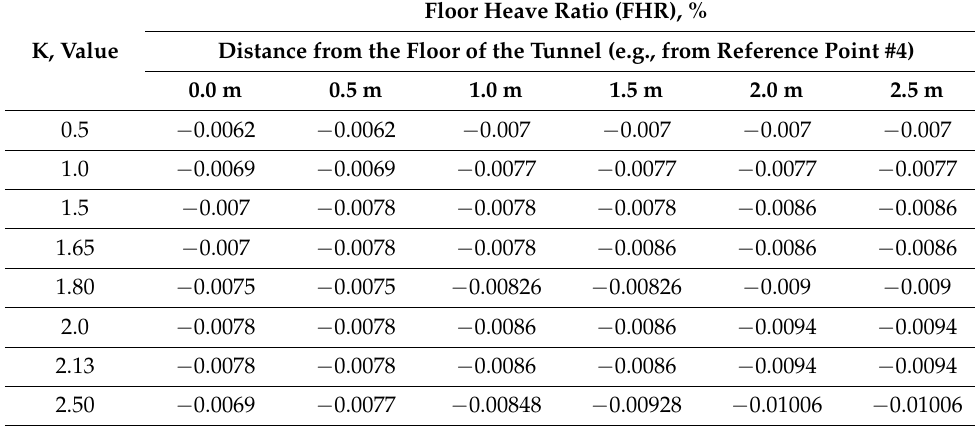
Figure 7. Vectors of vertical displacements of rock mass around tunnel boundary at in situ stress K of 2.5 after tunnel opening is created. Table 6. Ratio of floor heave (FHR) at various in situ stresses and different distances from the floor of the tunnel (e.g., from reference point